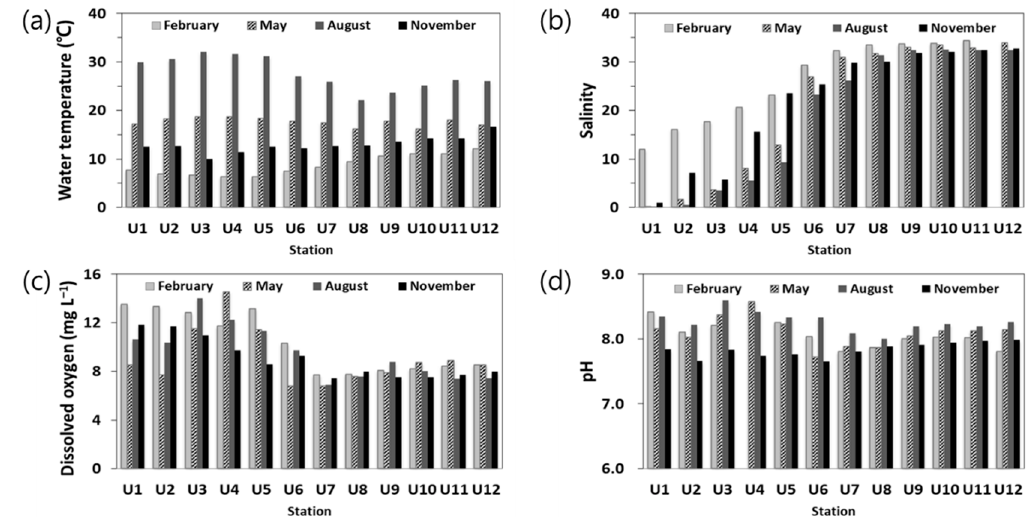
Figure 3. Spatiotemporal distributions of surface water environmental parameters in the Taehwa River estuary in Korea. ( a ) Water temperature, ( b ) salinity, ( c ) dissolved oxygen, and ( d ) pH. Salinity changes in the surface water ranged between 0.15–34.37 (average: 33.95) (Figure